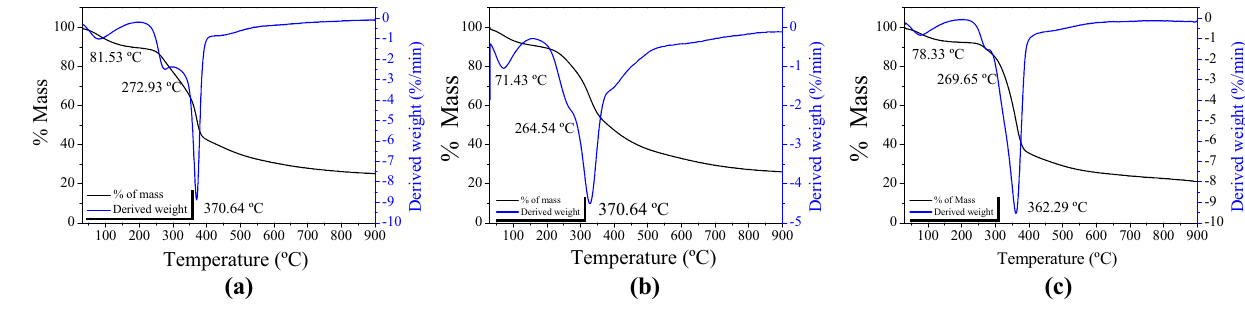
Fig. 4 Loss of mass (TG) and derived weight (DTG) of CNS chemically modified with H